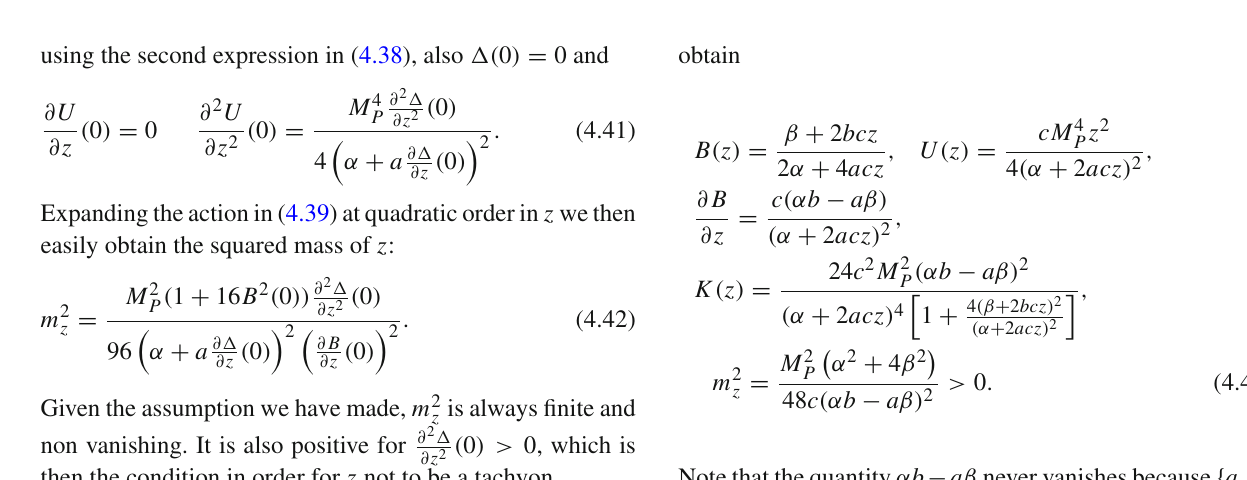
Fig. 1 Potential of the canonically normalized pseudoscalaron (for (cid:23)( R (cid:2) ) = c R (cid:2) 2 ) multiplied by c . Left plots: positive values of β . Right plots: negative values of